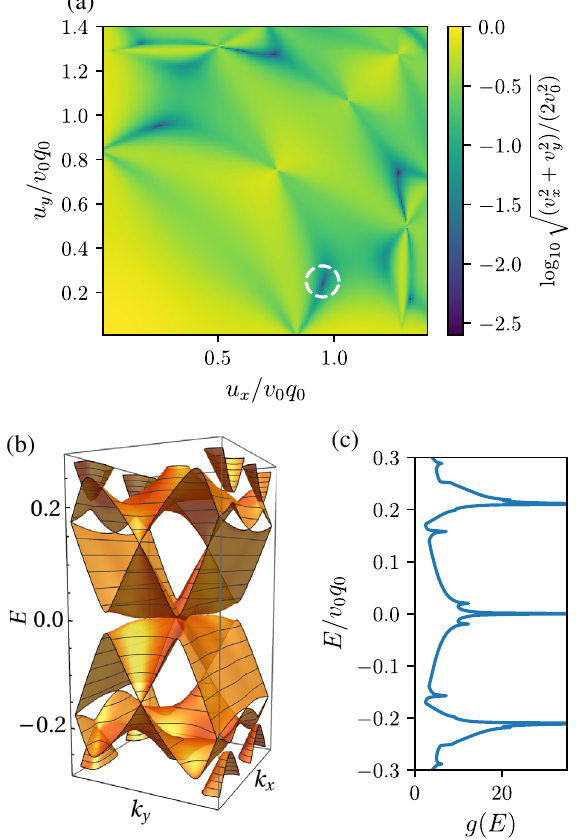
q ffiffiffiffiffiffiffiffiffiffiffiffiffiffiffi v 2 v 2 of the FIG. 5. (a) The “ absolute ” Dirac velocity x þ y Dirac cone at charge neutrality for the Hamiltonian Eqs. (13) and (16) as a function of u , u , in logarithmic scale. The dark x y spots are codimension-two manifolds on which the Dirac velocity vanishes entirely. (b),(c) Band structure and DOS of the Hamiltonian Eqs. (13) and (16) at the “ magic angle ” obtained 0 . 95 , u 0 . 25 [the point is marked by a circle in (a)]. with u x ¼ y ¼ We find a divergent DOS at charge neutrality with additional van Hove singularities at E ¼ (cid:3) 0 . 21